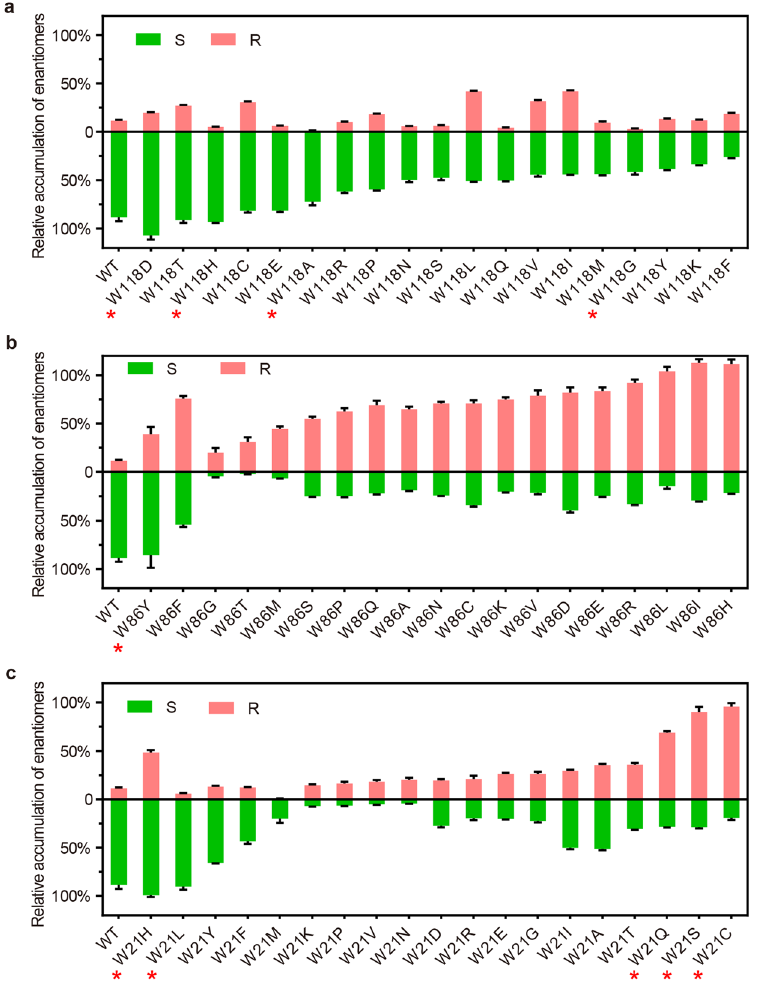
Figure 4. Investigation of the enantioselectivity of Tm1743 through saturation mutagenesis. The percentage of (S)-EHPB (green) and (R)-EHPB (salmon) produced by different saturation mutants of His118 ( a ), Trp86 ( b ) and Trp21 ( c ) are shown. The error bars represent the standard deviation from triplicate experiments. Important mutants with representative features are highlighted with red stars ( *